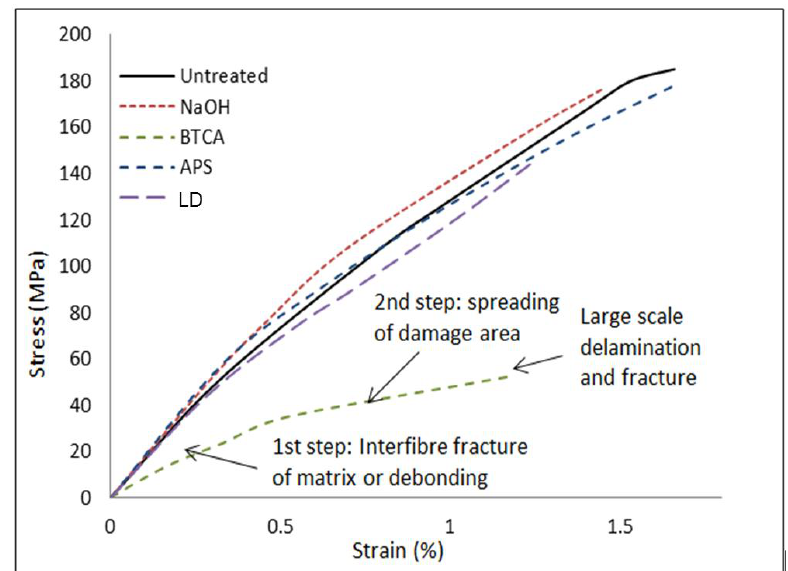
Figure 6. Stress-strain curves of hybrid FE